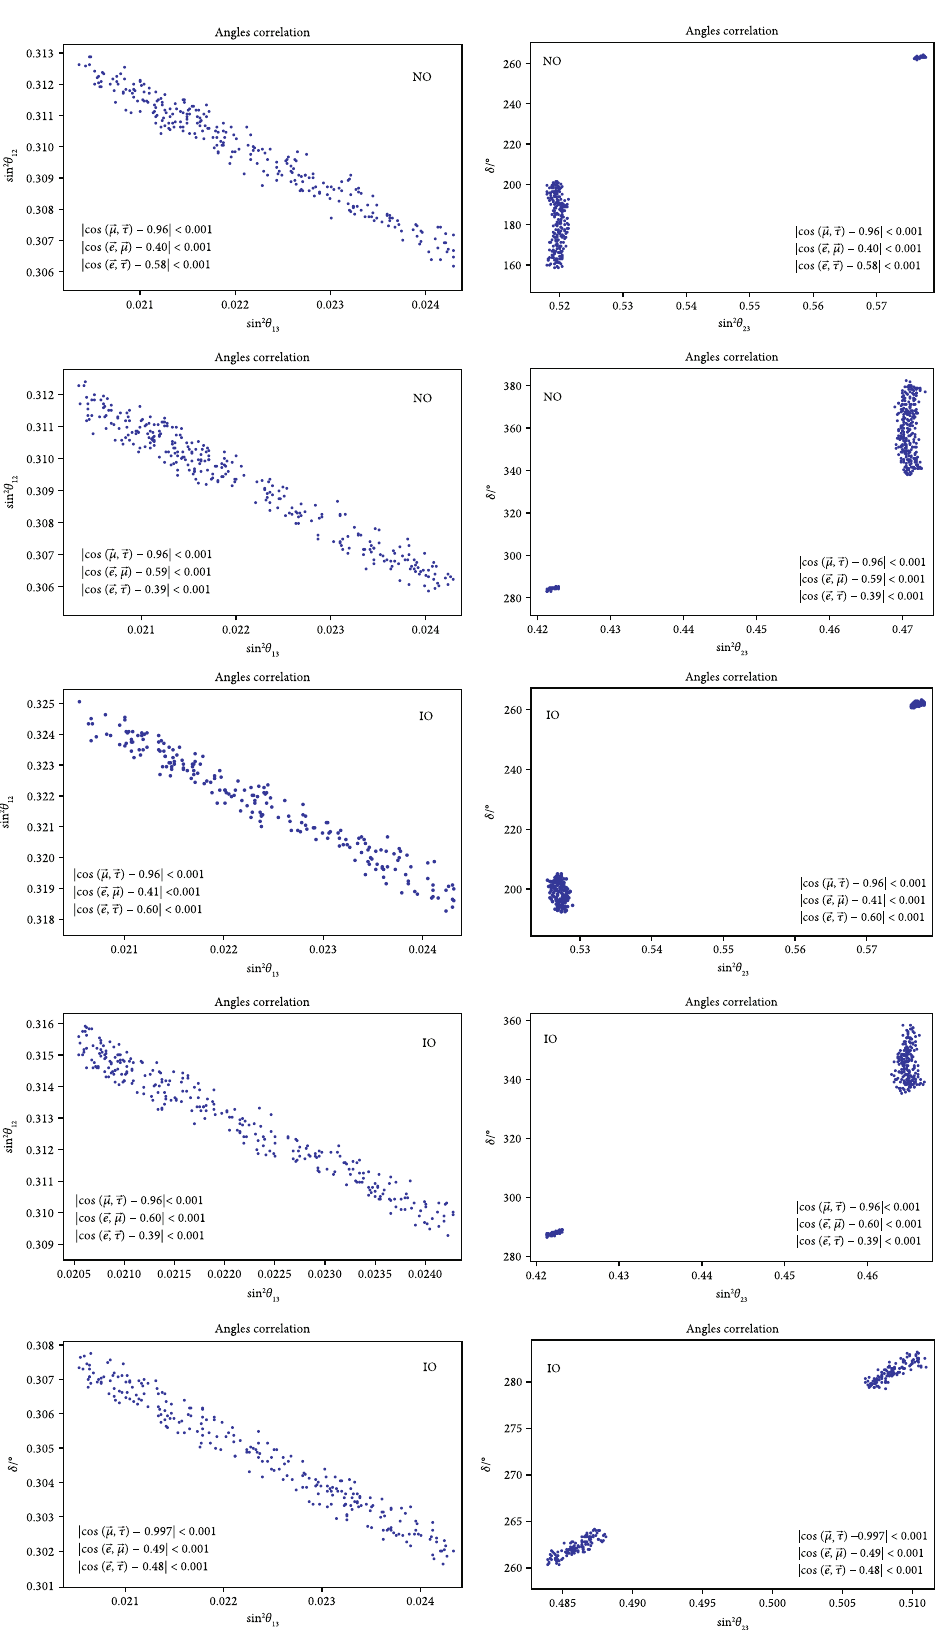
Figure 10: The correlations of sin 2 θ